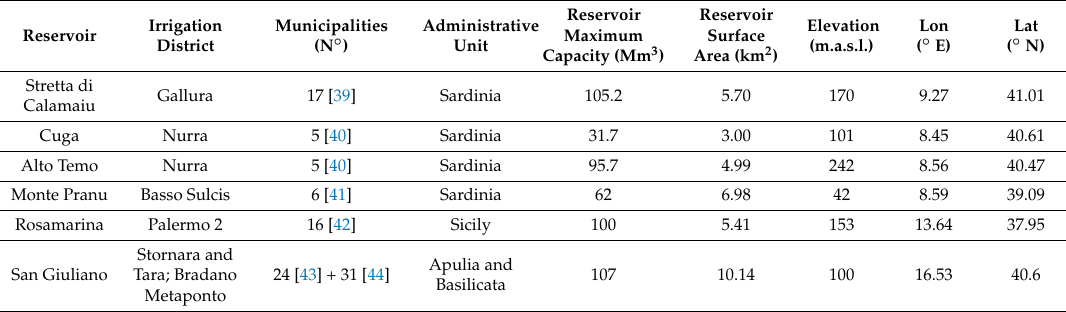
Table 1. Selected Italian reservoirs with irrigation as main use (data from Lehner et al. [38]).